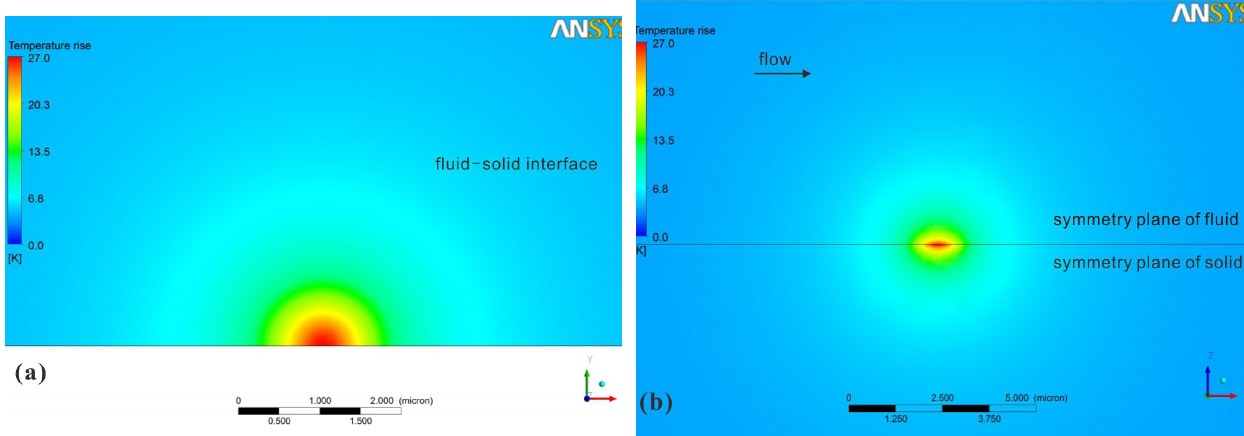
Figure 3. Temperature profile of the computational fluid dynamic (CFD) simulation in such a circumstance: water as the working fluid, P = 10 mW, d = 1 μm and U = 0.01 m·s − 1 . ( a ) At the fluid–solid interface and ( b ) at the symmetry planes of both fluid and solid